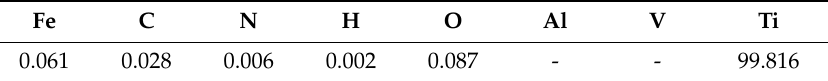
Table 9. Chemical composition of sheet TA2 (wt. %).